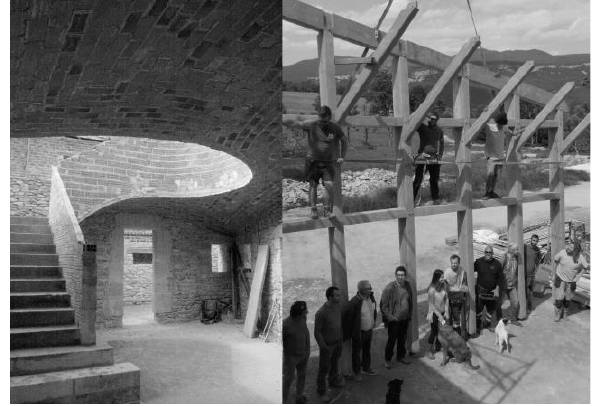
Figure 9. Catalan vaulting and massive wooden frame,